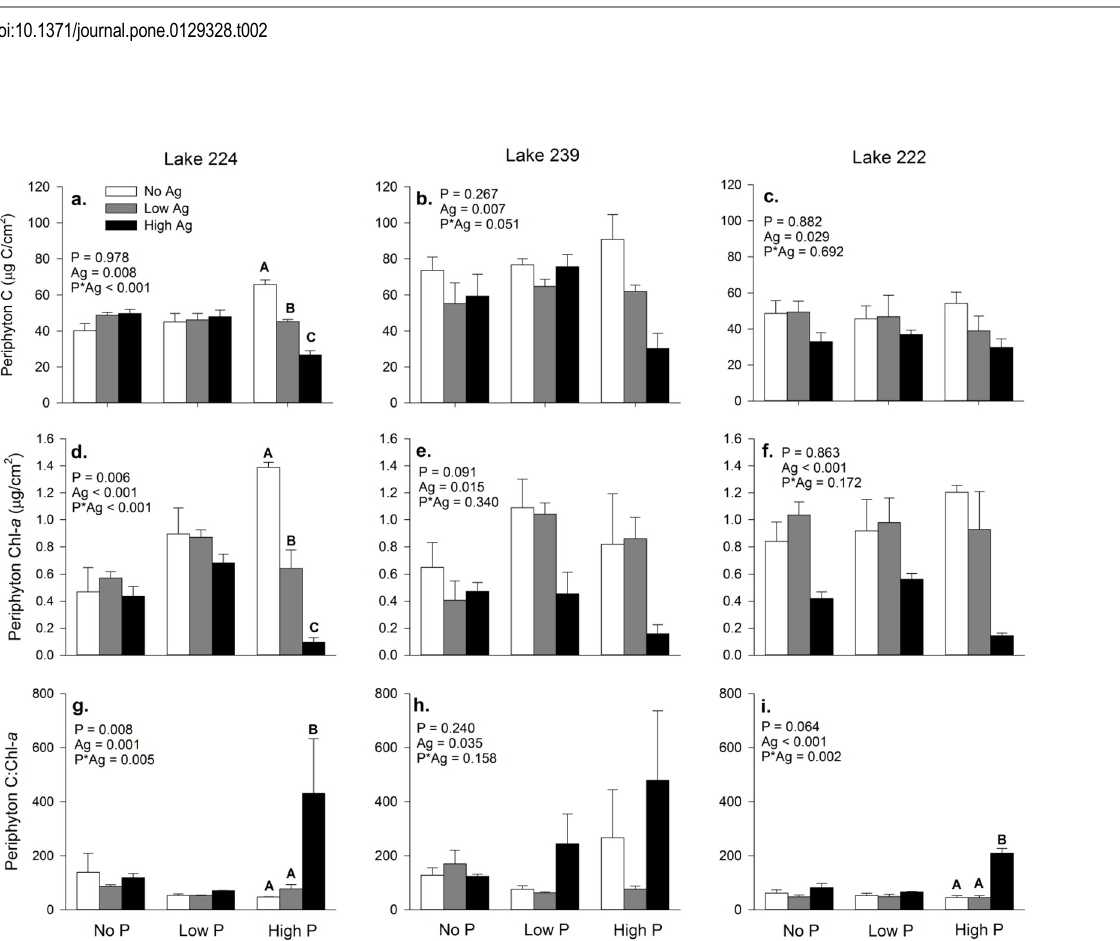
Values are averages of three replicate substrates. bd indicates Ag measurements that were below detection. Means within the same lake with different lowercase letters are signi fi cantly different ( p < 0.05).